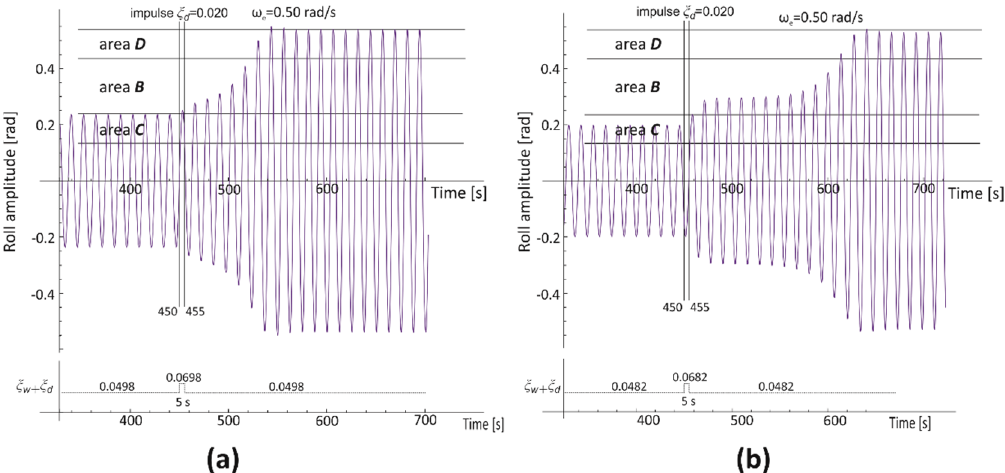
Figure 10. Roll time history for the OSV vessel (T = 6.10 m, GM0 = 2.50 m, ξ w,(a) = 0.0498, ξ w,(b) = 0.0482). The transition from the bistability area C to the resonance area D is caused by the additional exciting moment ξ d (450–455 s): ( a )—the initial and stable roll amplitude is below but very close to the upper limit of the bistability area C; ( b )—the initial and stable roll amplitude is below but not so close to upper limit of the bistability area C .